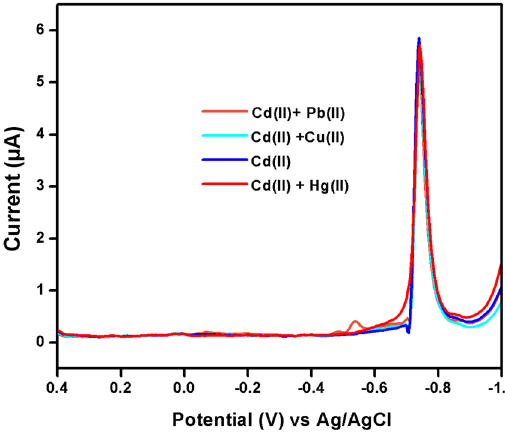
Figure 9. Effect of interference species on the detection of cadmium at MnCo 2 O 4 . Peak current response of 50 μ g L − 1 Cd (II) in the presence of 3-fold of Cu 2 + , Pb 2 + and Hg 2 + .